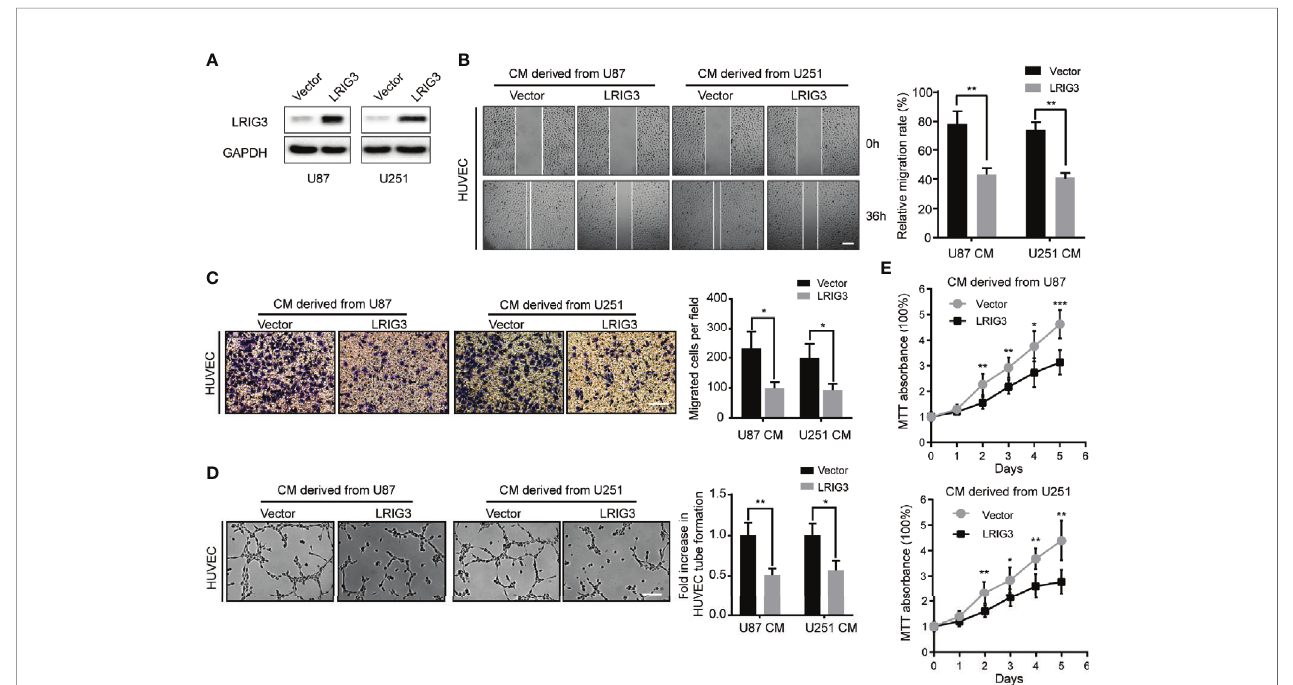
FIGURE 1 | Ectopic expression of LRIG3 reduces the pro-angiogenic activity of glioma cells in vitro. (A) Western blots showing levels of LRIG3 expression in the vector control and LRIG3-transduced glioma cells. GAPDH was used as an internal control. (B) Representative images (left) and quanti fi cation (right) of wound healing assays in HUVECs treated with CM derived from the vector control or LRIG3-transduced glioma cells. (C) Representative images (left) and quanti fi cation (right) of transwell migration assays of HUVECs treated with the indicated CM. (D) Representative images (left) and quanti fi cation (right) of HUVECs formed tube-like structures on Matrigel-coated plates with CM derived from the vector control or LRIG3-transduced glioma cells. (E) HUVEC viability was determined using the MTT assay. HUVECs were treated with CM derived from the indicated cells for the speci fi c number of days. Data are means ± SD of 3 replicates. * p < 0.05; ** p < 0.01; *** p < 0.001. CM, conditioned